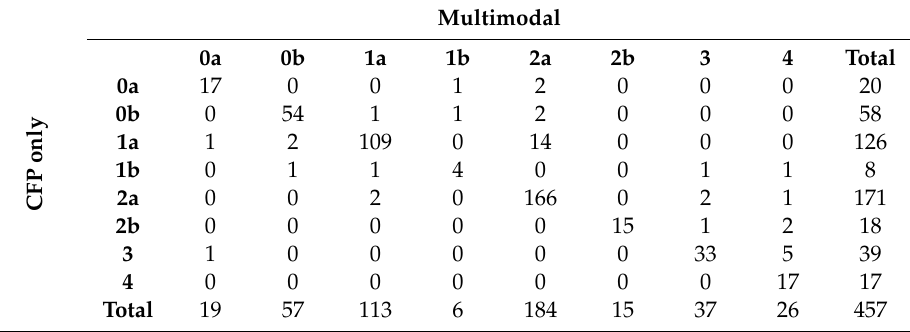
Figure 1. Frequency distribution of differential grading cases, by stage and grading approach. Table 3. Crosstab of the distribution of AMD stages based in CFP only and based in the multimodal